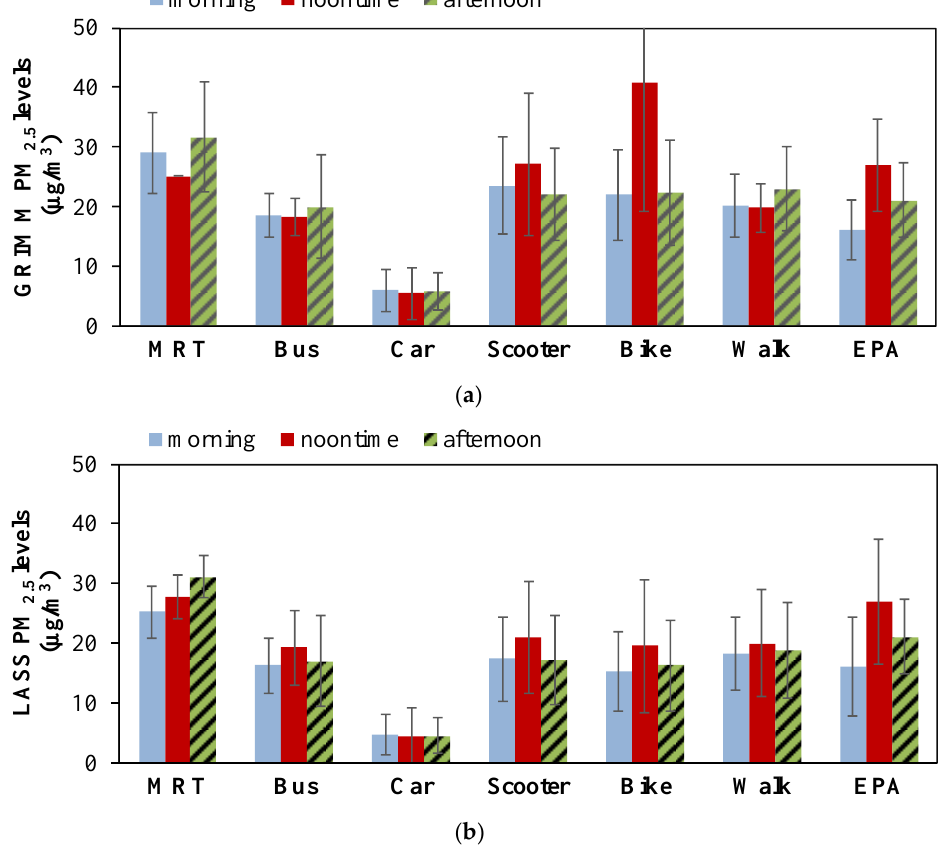
Figure 3. PM 2.5 levels in six transportation modes obtained from ( a ) GRIMM and ( b ) LASS (converted) along with those of Taiwan Environmental Protection Agency during the monitoring periods; error bars represent standard deviations of these measurements.